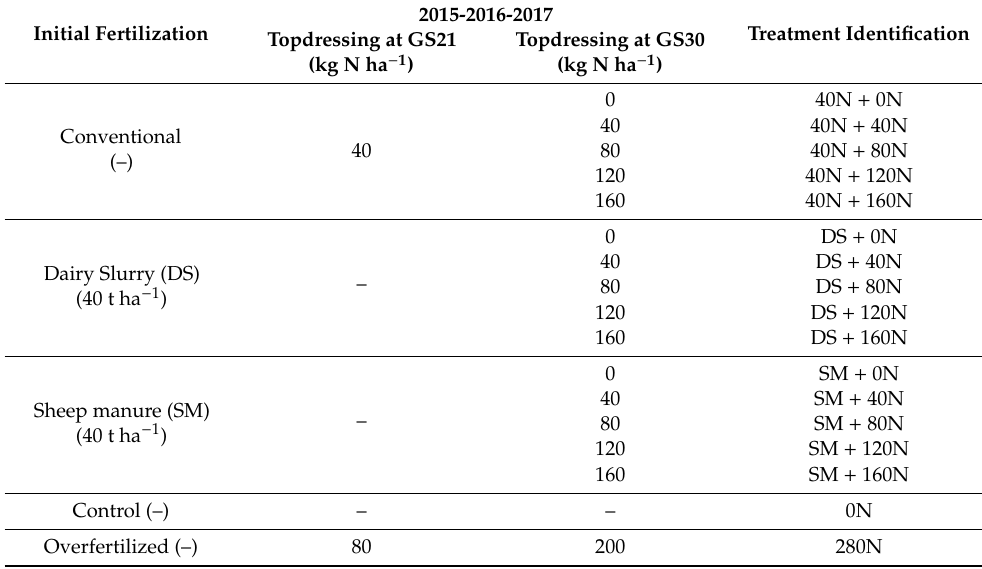
Table 1. Fertilization treatments for the field trials (2015, 2016, and 2017) and the N dose applied in each of them. Beginning of tillering (GS21; end of winter [26]) and stem elongation (GS30; [26]). Initial